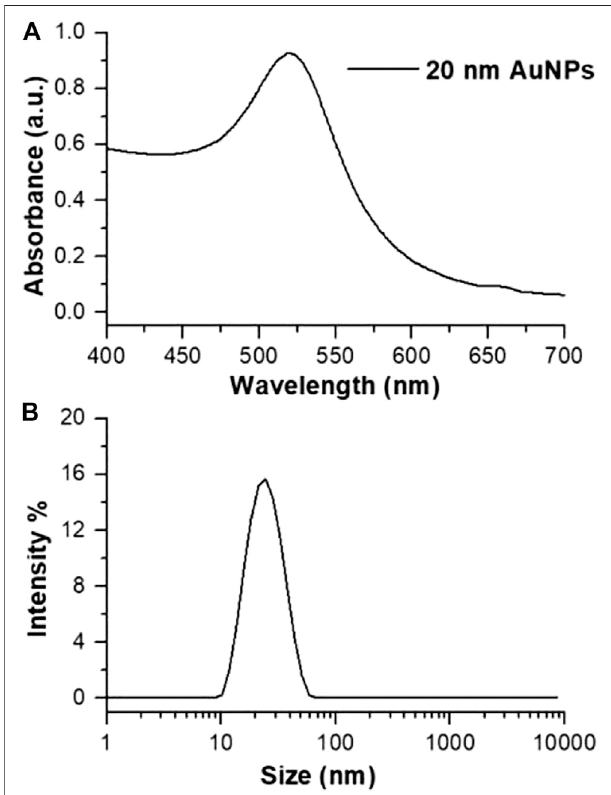
FIGURE 1 | (A) Absorption spectrum and (B) size distribution by intensity of synthesized citrate@AuNPs in water.